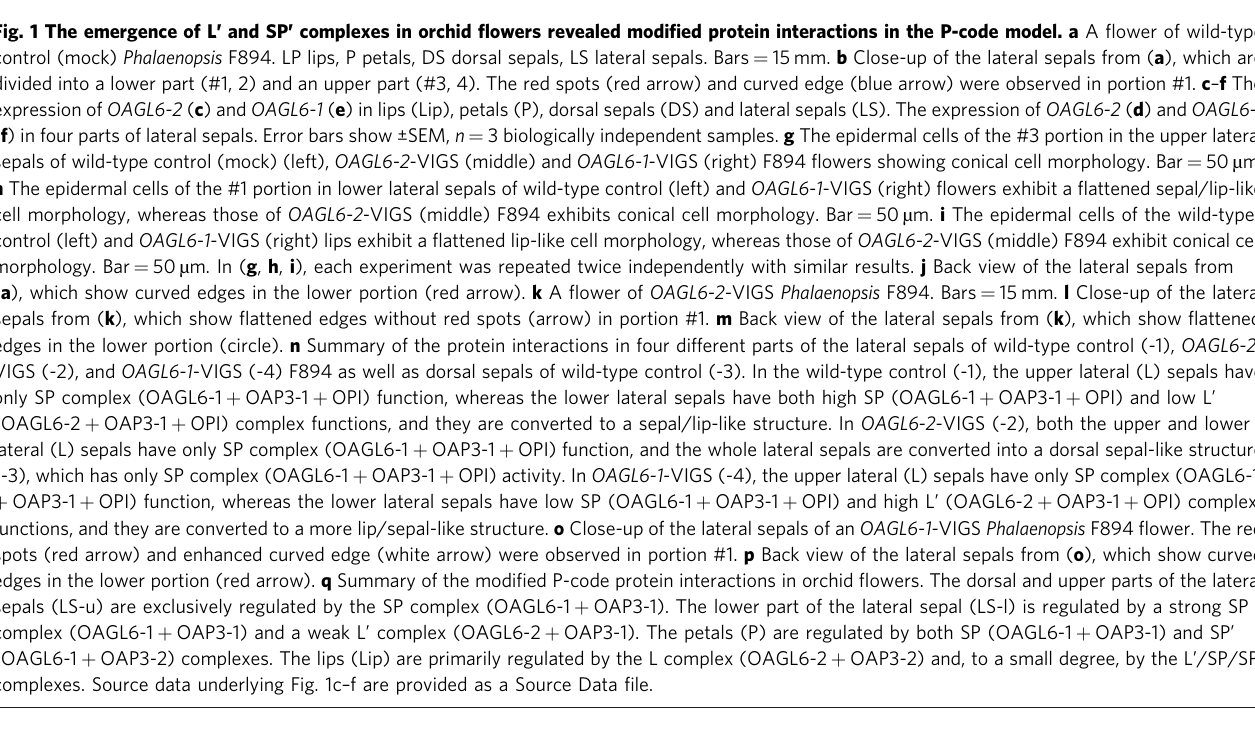
Fig. 1 The emergence of L ’ and SP ’ complexes in orchid fl owers revealed modi fi ed protein interactions in the P-code model. a A fl ower of wild-type control (mock) Phalaenopsis F894. LP lips, P petals, DS dorsal sepals, LS lateral sepals. Bars = 15 mm. b Close-up of the lateral sepals from ( a ), which are divided into a lower part (#1, 2) and an upper part (#3, 4). The red spots (red arrow) and curved edge (blue arrow) were observed in portion #1. c – f The expression of OAGL6-2 ( c ) and OAGL6-1 ( e ) in lips (Lip), petals (P), dorsal sepals (DS) and lateral sepals (LS). The expression of OAGL6-2 ( d ) and